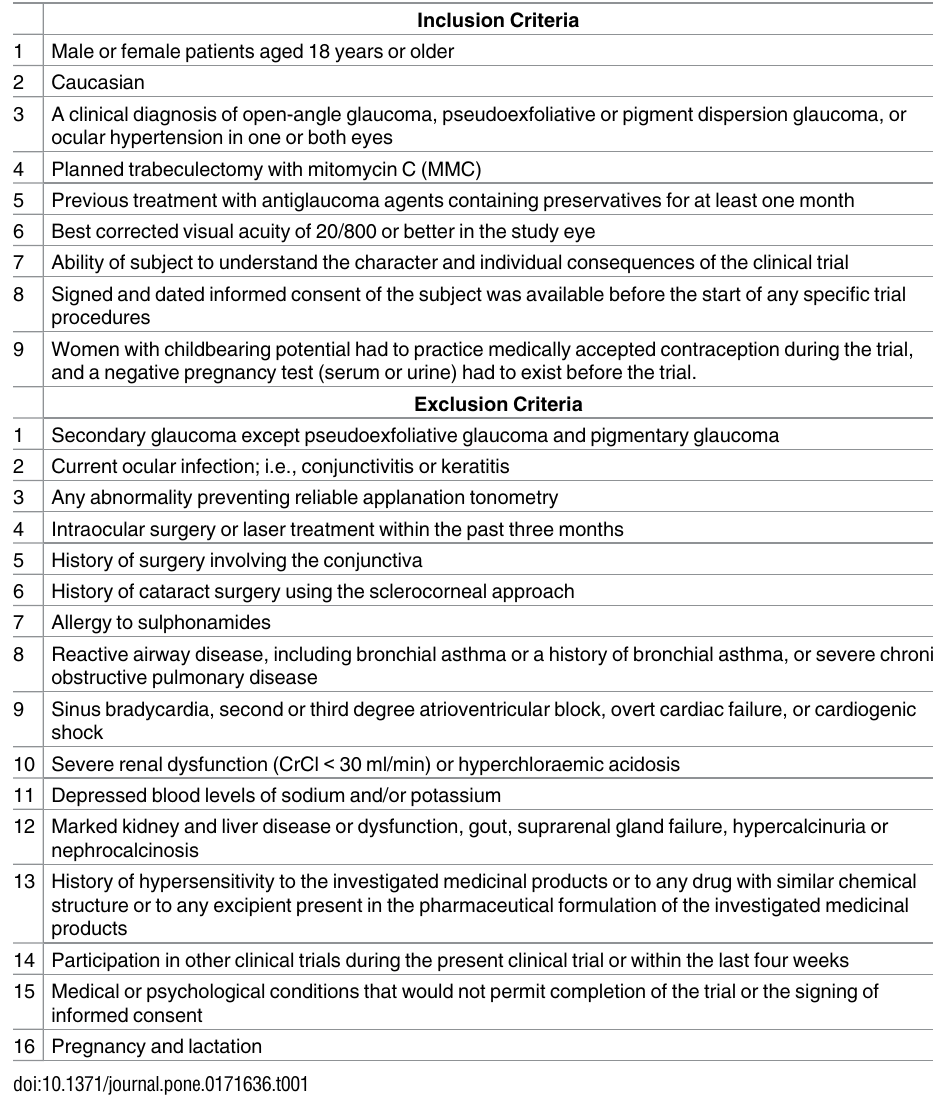
Table 1. In- and exclusion